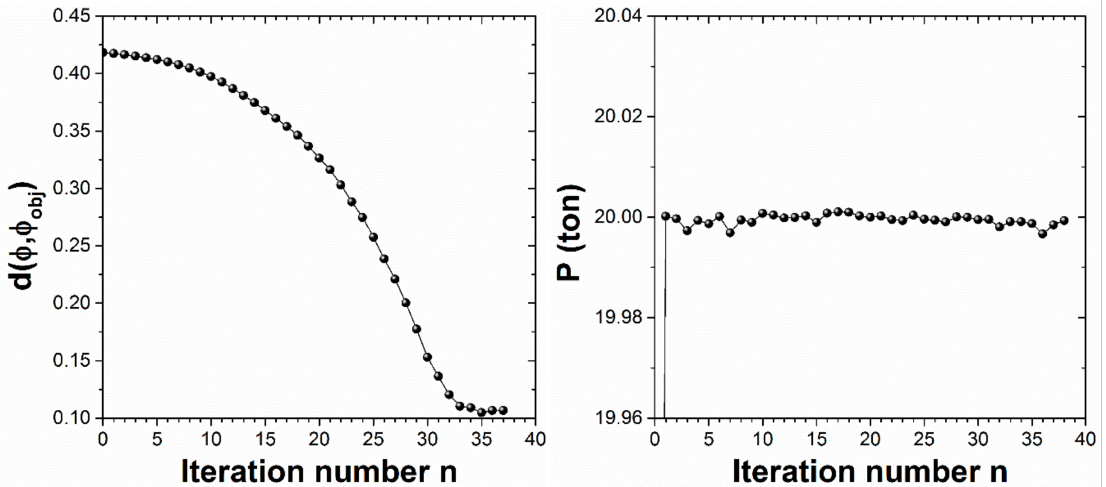
Figure 2. Evolutions of the distance d and of the weight P of the device with the iteration number n